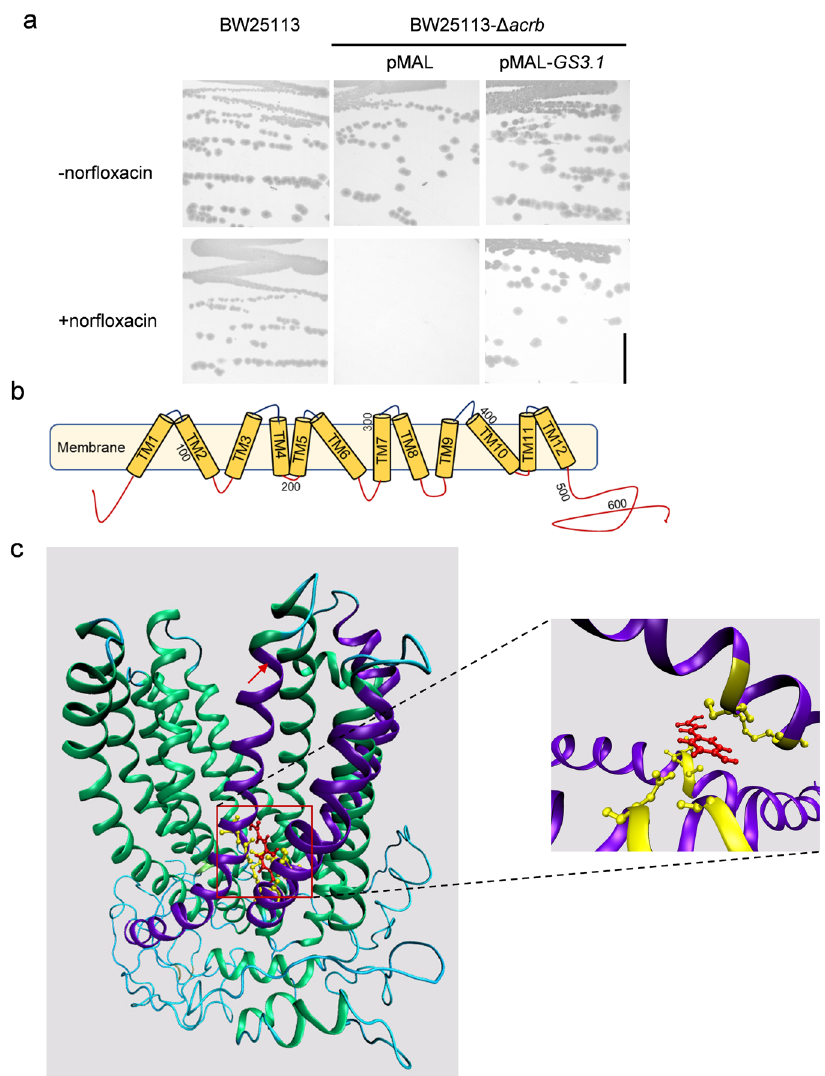
Fig. 4 GS3.1 functions as a MATE transporter and might transport p -coumaric acid in rice. a Growth complementation assays of the E. coli Δ acrB mutant expressing GS3.1 HJX on medium supplemented with the antibiotic nor fl oxacin. The E. coli Δ acrB mutant expressing pMAL empty vector and the wild-type E. coli BW25113 were used as control strains, and mediums without nor fl oxacin were used as the growth condition control. Scale bar = 1 cm. b A schematic of the predicted GS3.1 structure showing 12 transmembrane helixes. Numbers indicate the sequence number of amino acid residues. c Predicted GS3.1 model docked with p -coumaric acid (red). The α -helixes interacting with p -coumaric acid were colored purple. The amino residues interacting with p -coumaric were colored yellow. The red arrow indicates the key α -helix for its transporter